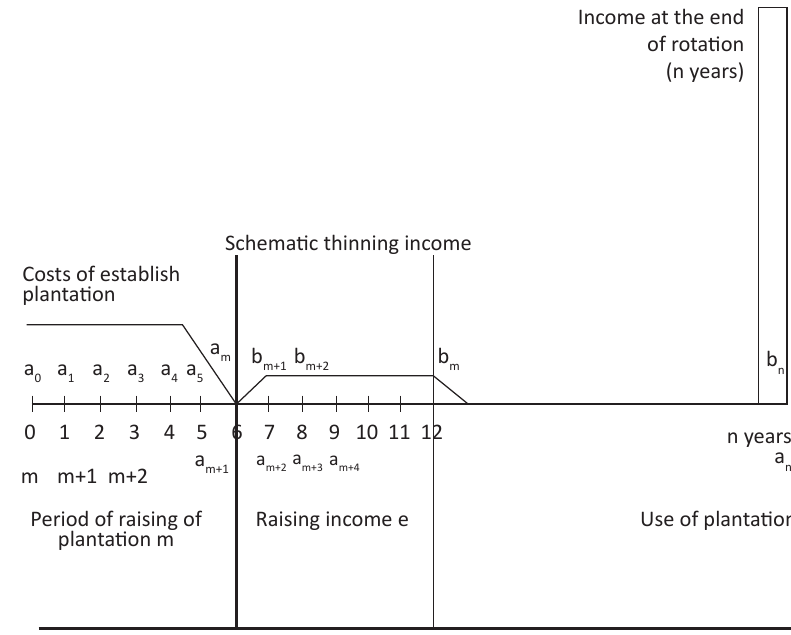
FiGURe 2. Developed model of investment in the establishment of multiannual plantations (Source: